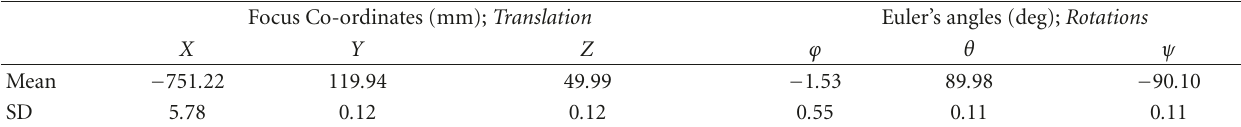
Table 1: An example of the 3D pose parameters of the calibration model, estimated via a single camera calibration by means of the metallic markers.